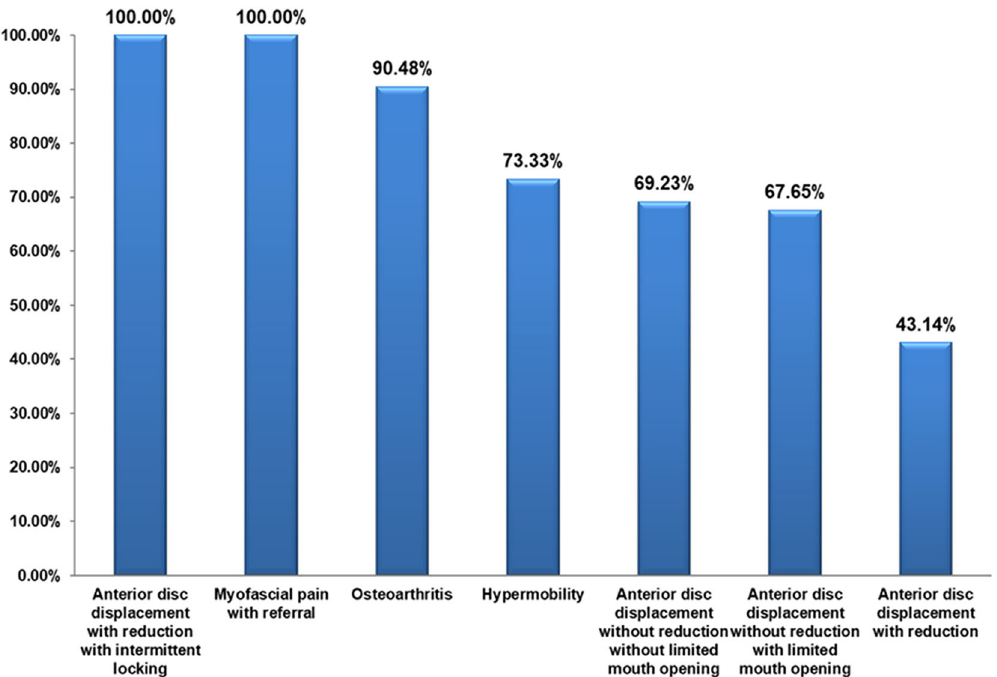
Figure 2. Prevalence of referred pain in different DC/TMD